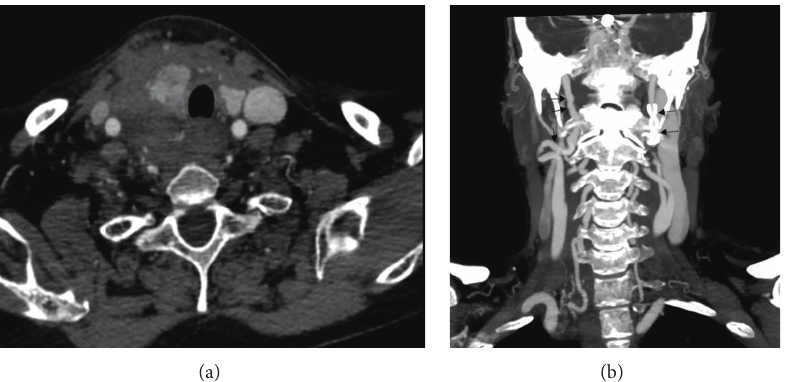
Figure 1: Contrast-enhanced angiographic CT (CTA). (a) Contrast-enhanced CT angiography in axial view shows the large right cervical hematoma causing anterior displacement of the right thyroid lobe and slight tracheal deviation to the left. (b) CT angiography in coronal maximal intensity projection (MIP) reformation showing the classical “strings of beads” sign in the right ICA (black arrows), typical for FMD, the stent in the left ICA (black dashed arrows), and the coil in the paraophthalmic segment of the right ICA (black arrow). No active bleeding is seen.